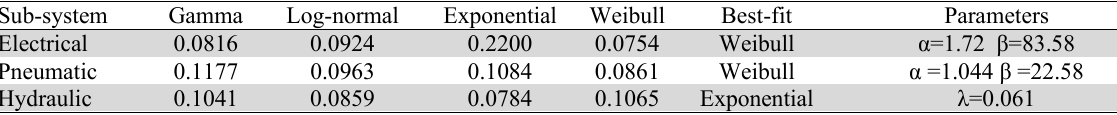
Fig. 4 . Results of serial correlation test for TBF and TTR data The results of best-fit distributions for TBF data set